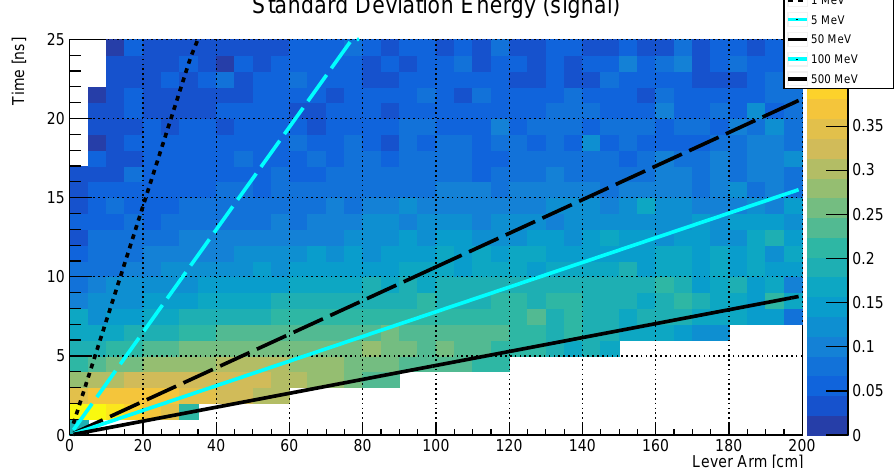
Figure 138. The fractional resolution of the reconstructed neutron kinetic energy for leading (first in time) neutrons created from neutrino events inside the fiducial volume of the 3DST. The axes are the time and distance of the neutron cluster from the neutrino vertex. The lines indicate specific neutron kinetic energies. This plot was made with a ¯ ν µ -CC inclusive sample of